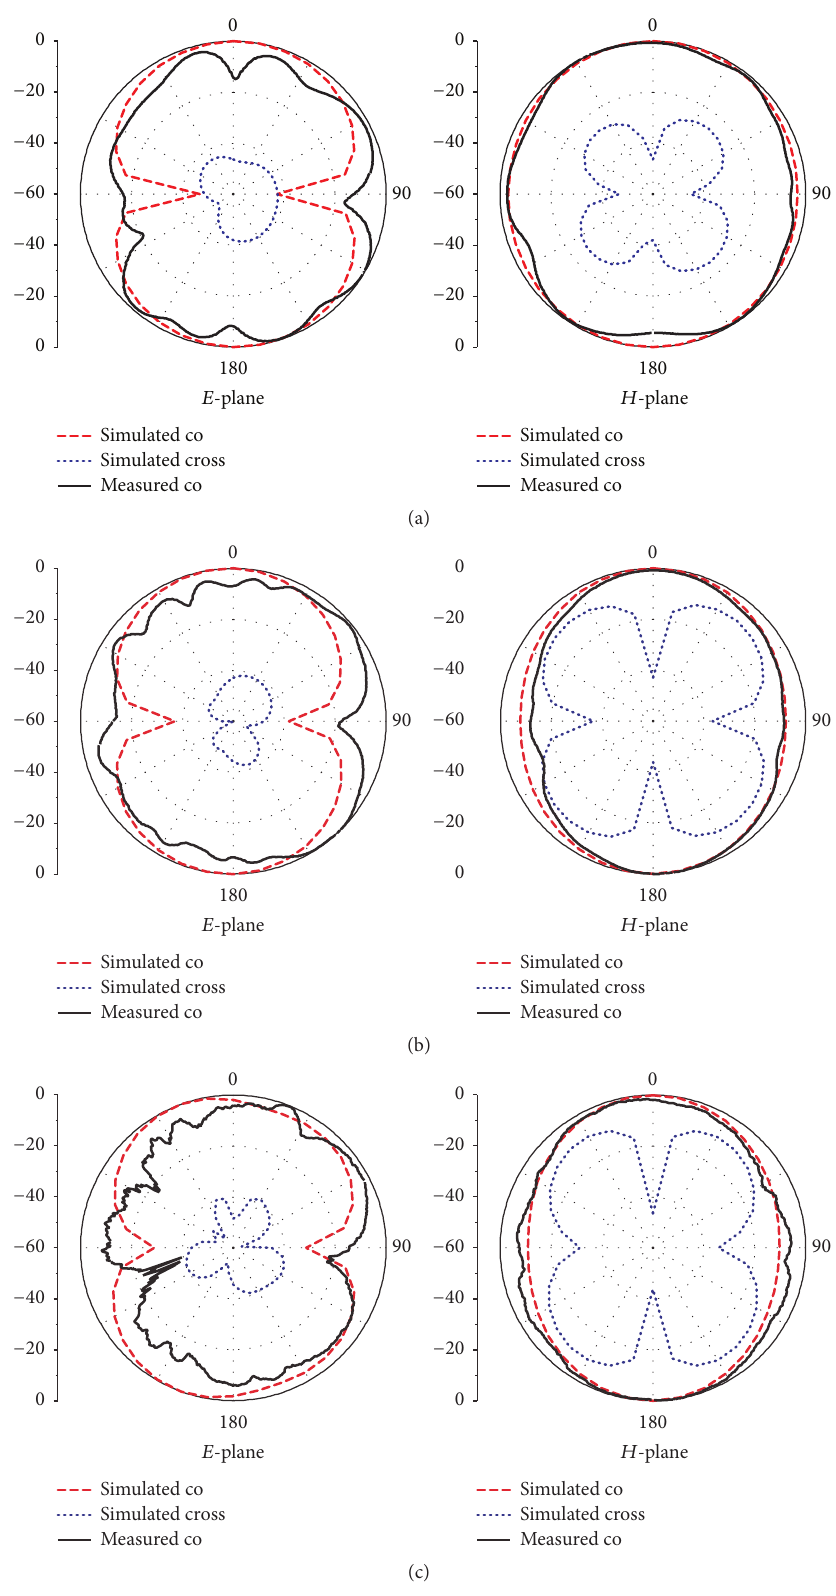
Figure 10: Simulated and measured radiation pattern at (a) 3GHz, (b) 6 GHz, and (c)